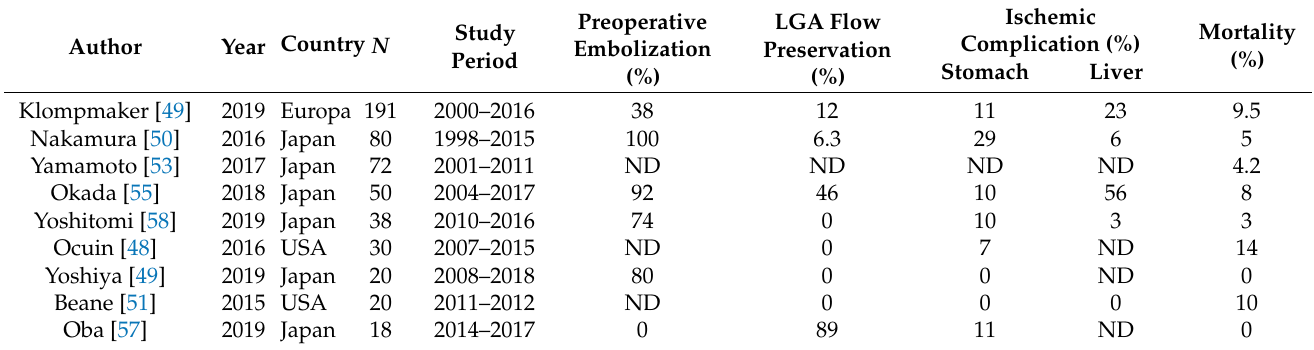
Table 3. Previous reports of distal pancreatectomy with celiac axis resections